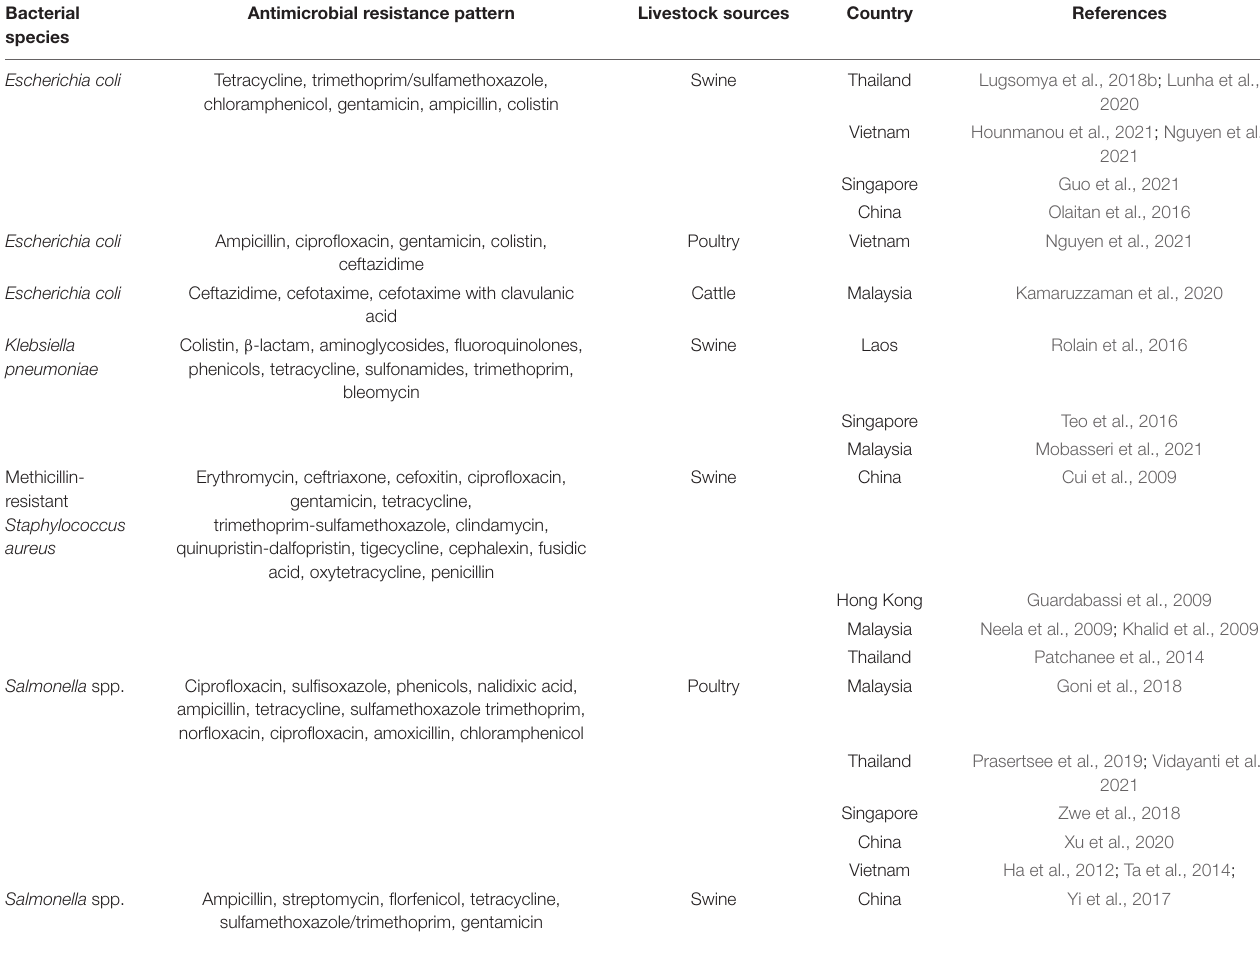
TABLE 3 | Reported occurrence of livestock associated ARB in